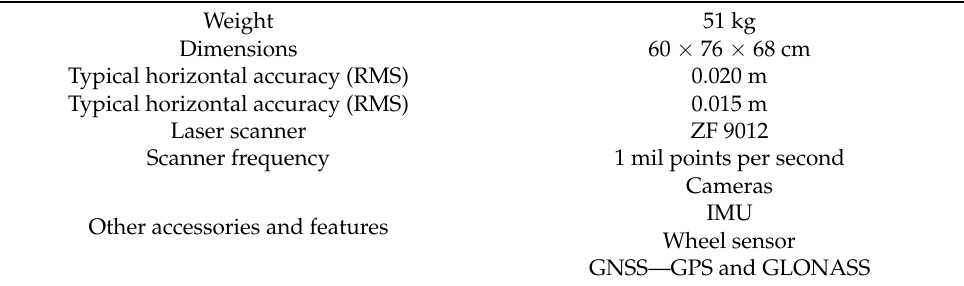
Table A3. Basic characteristics of Leica Pegasus Two